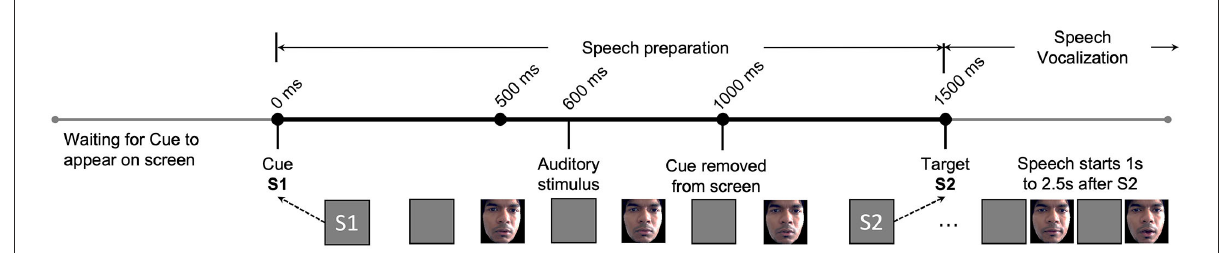
FIGURE2 Experimental paradigms and their timing diagram is illustrated. Here, S1 represents the Cue where the trial begins. S2 represents the Target where a vocal response from subject is requested. The EEG and facial activity inputs to our proposed machine learning model are strictly limited to between S1 and S2 during the speech preparation phase. The speech vocalization phase is immediately after S2, and speech usually happens 1–2.5 s after S2 based on the individuals stuttering severity. Changes in the facial muscles of the first author are illustrated as an example, shared after approval and